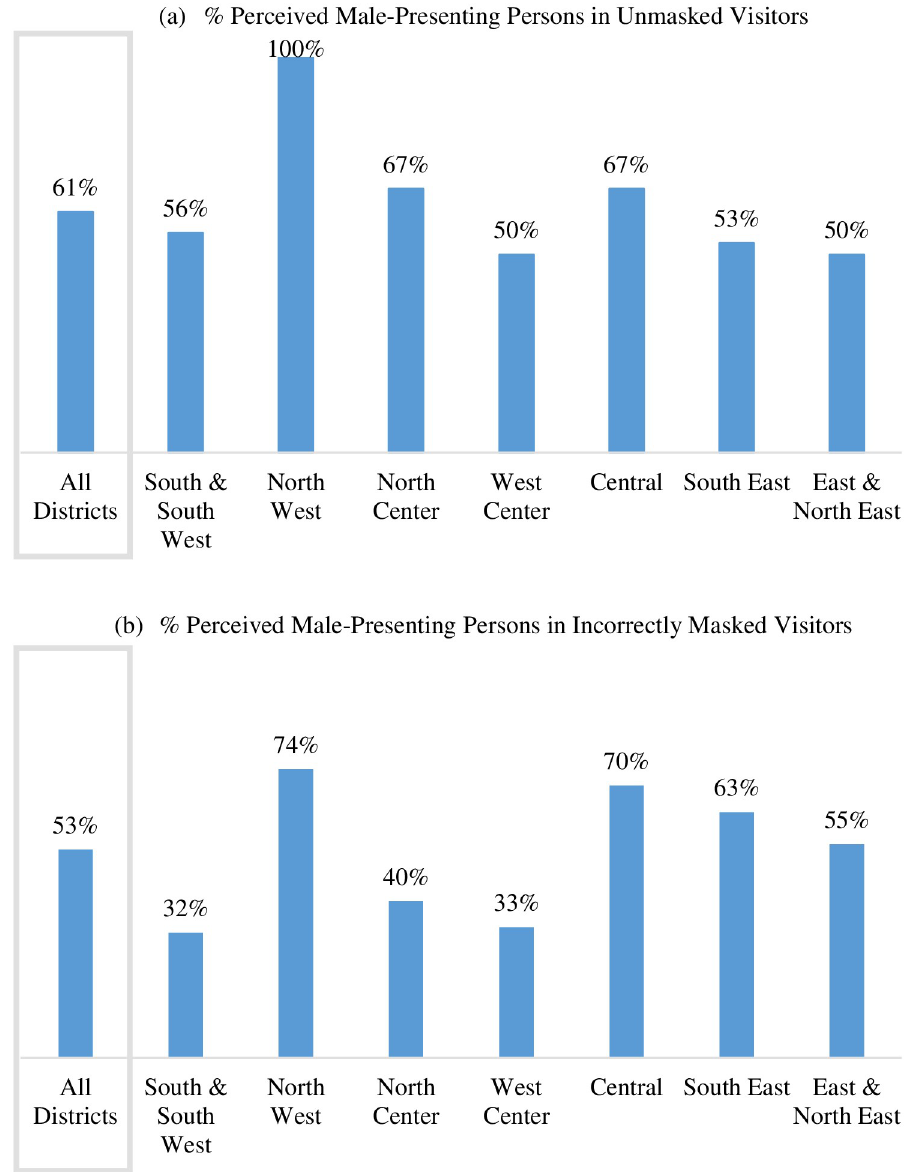
Fig 4. Percentage of perceived male-presenting persons among unmasked and incorrectly masked visitors by